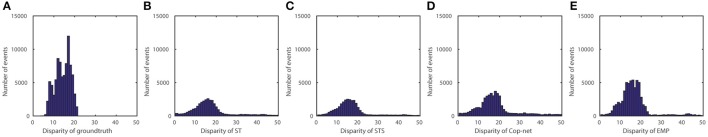
Results of the fifth scene (One person different depth). The events disparity histogram within time of 5s. From the left to right, the result is extracted by (A) Ground Truth, (B) ST, (C) STS, (D) cooperative network, and (E) our method.